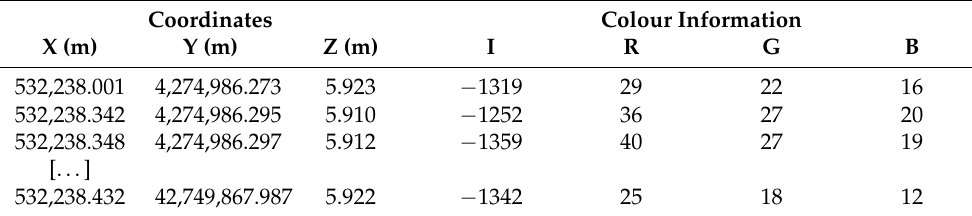
Table 1. Typical structure of a point cloud